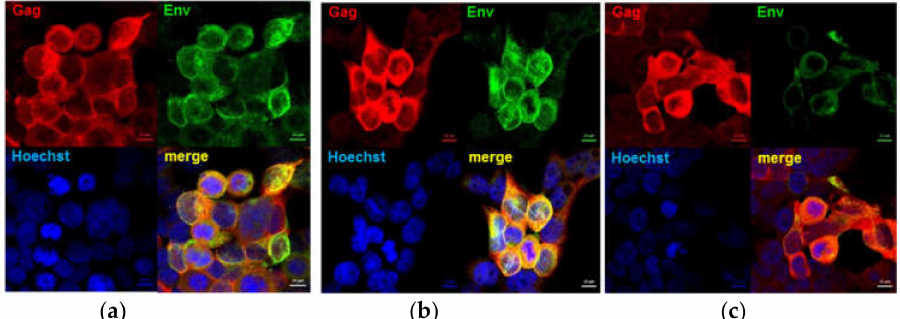
Figure 2. Confirmation of expression of chimeric envelope proteins and Gag. Confocal images of HEK293T cells infected with MVA show that both Env (green, Cy3) and Gag (red, Alexa Fluor 647) were expressed by all three vaccines. ( a ) MVAGC5 (Gag M + gp150), ( b ) MVAGC2 (Gag M + gp120HA 2 ), and ( c ) MVAGC4 (Gag M + gp140HA 2